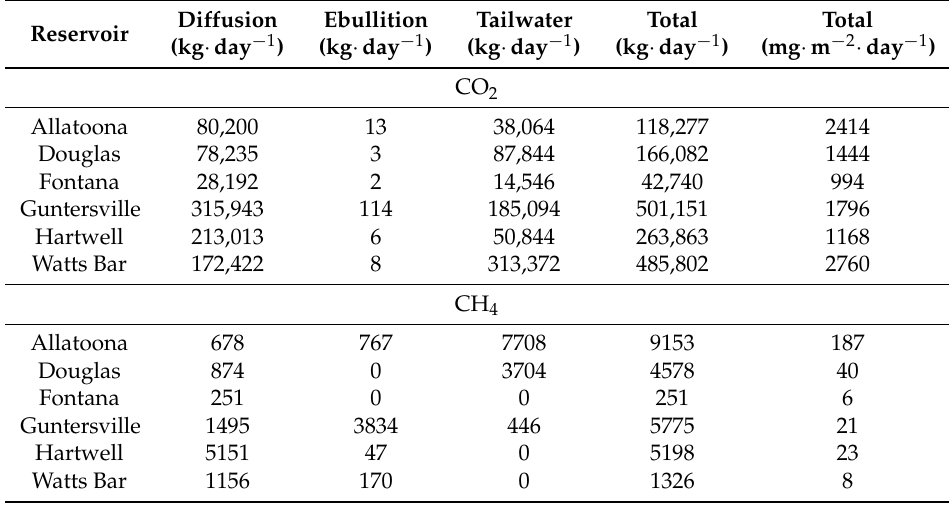
Table 3. Total CO 2 and CH 4 releases from six southeastern U.S. hydropower reservoirs through diffusive emission, ebullition, and tailwater